Question: Provide a publication-style caption for this figure.
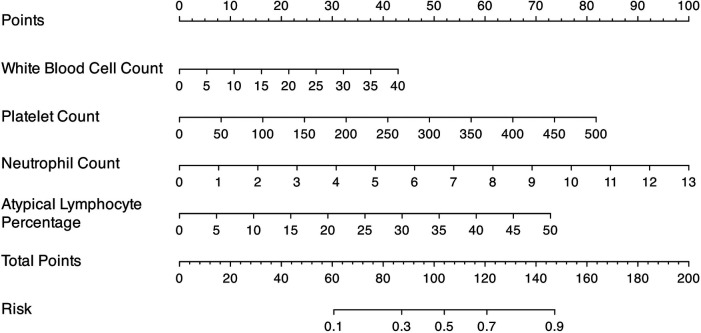
Answer: Nomogram for predicting the risk of prolonged fever in immunocompetent children with primary EBV infection. The total score, calculated by summing the points assigned to the four parameters (WBC, NEU, PLT, and AL), corresponds to the predicted probability of fever duration >1 week. EBV, Epstein–Barr virus; WBC, white blood cell count; NEU, neutrophil count; PLT, platelet count; AL, atypical lymphocyte proportion.